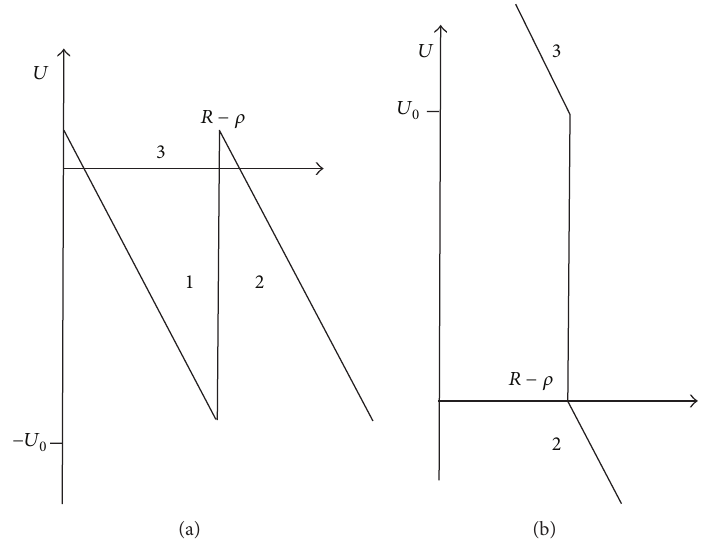
Figure 3: A sketch of the potential in the mirror surface vicinity is shown for the case of attractive (a) and repulsive (b) optical Fermi- potentials. The potential step at 𝜉 = 0 is equal to the mirror optical potential 𝑈 0 . The potential slope at 𝜉 ̸= 0 is governed by the centrifugal effective acceleration 𝑎 = V 2 /𝑅 . The regions, responsible for different type of resonances, are indicated with numbers: 1: long-living quasi- bound states, 2: surface waves, and 3: narrow over-barrier